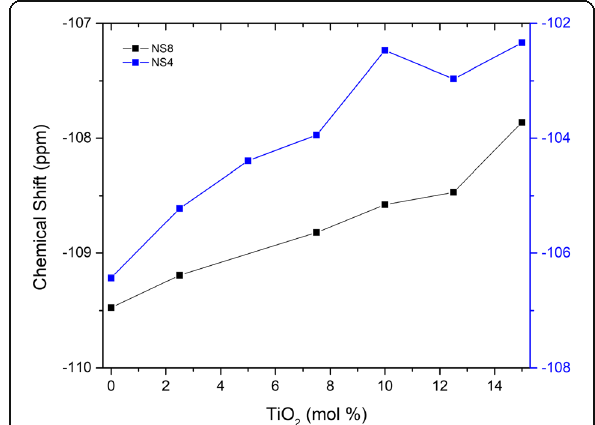
Fig. 5 Position of the 29 Si NMR Q4 peak as a function of bulk TiO 2 content of the glasses for NS4 (blue) and NS8 (black) compositions. The systematic shift in frequency is likely due to the continuous growth of an additional Q4 peak due to [4] Ti nearest-neighbor interactions with Q4 Si. Peak fitting of the spectra was performed using Gaussian peaks, with fit iterations converging at a chi-squared tolerance value of 1E-6